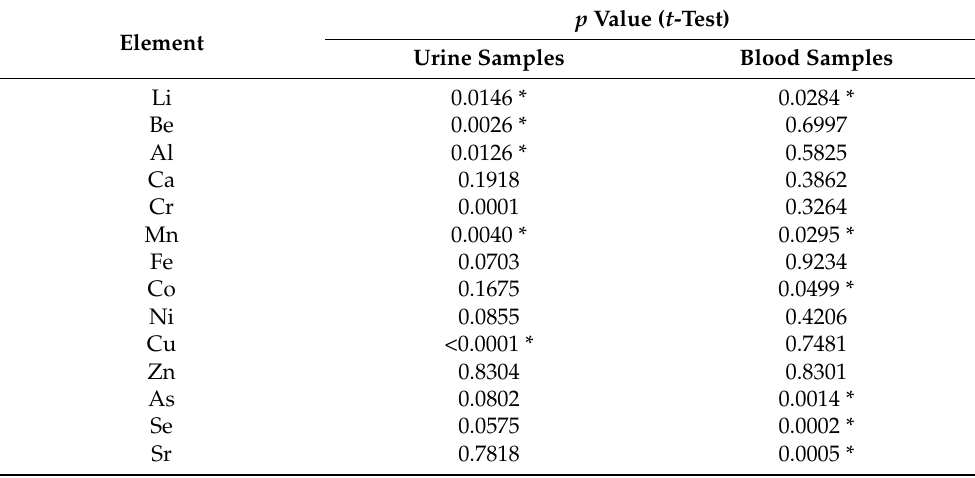
Table 3. Comparison between urine and blood samples from the control and exposed groups ( p